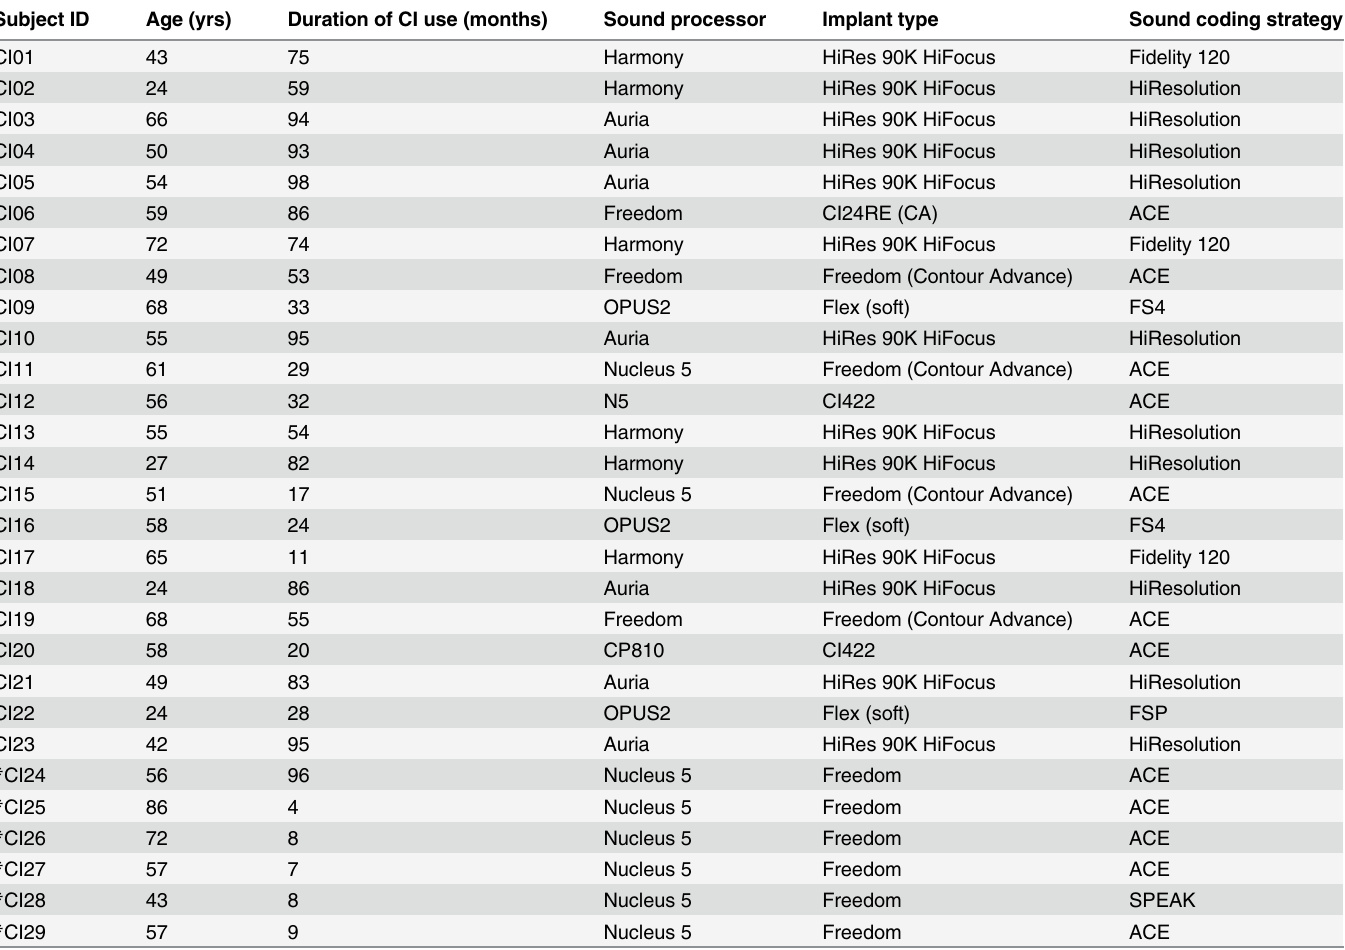
Table 2. Cochlear implant (CI) subject demographics. Subjects labeled with asterisks (CI24-CI29) participated in the experiment where test-retest reli- ability for the STM detection test was